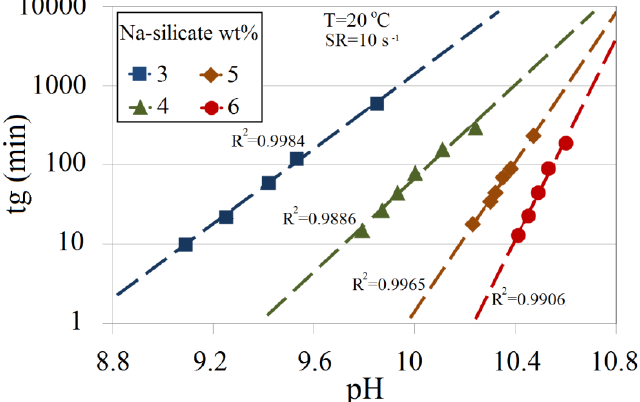
Figure 5. Gelation times as a function of pH for 3 wt%, 4 wt%, 5 wt% and 6 wt% Na-silicate